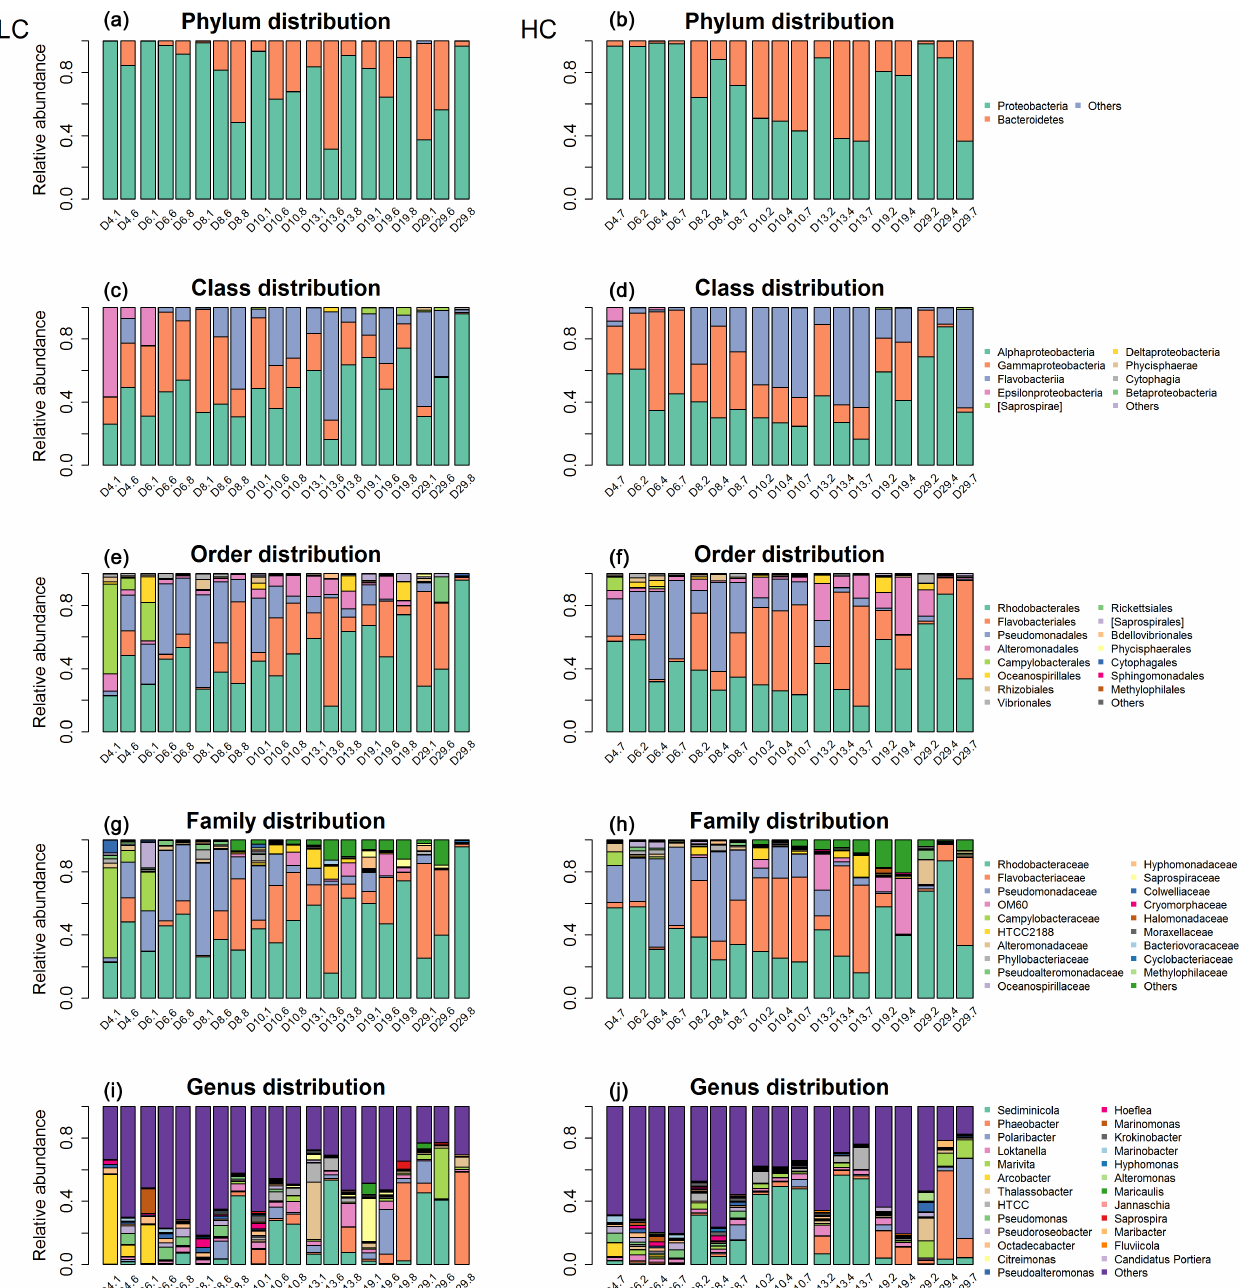
Figure 2. Bacterioplankton community structure overview at different taxonomic levels during days 4, 6, 8, 10, 13, 19 and 29 (#1, #6, #8) under LC and HC (#2, #4, #7). The x axis represents sample name (for example, D4.1 refers to bacterioplankton in mesocosm bag 1 collected at day 4) and the y axis represents the relative abundance of different groups of bacterioplankton.